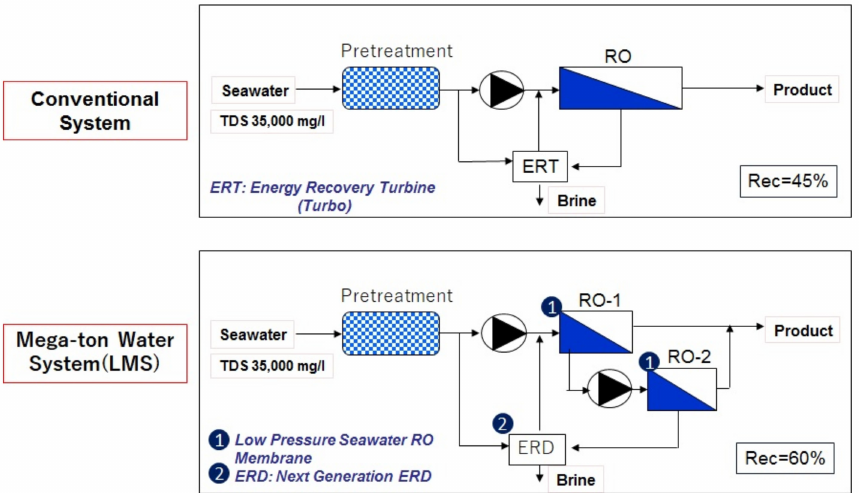
Figure 14. Comparison of flow diagram for conventional Seawater Reverse Osmosis (SWRO) system and the “Mega-ton Water System” (Low-Pressure, Multi-Stage System (LMS)) [25–27]. (III) What energy saving can achieve with and without advanced energy recovery